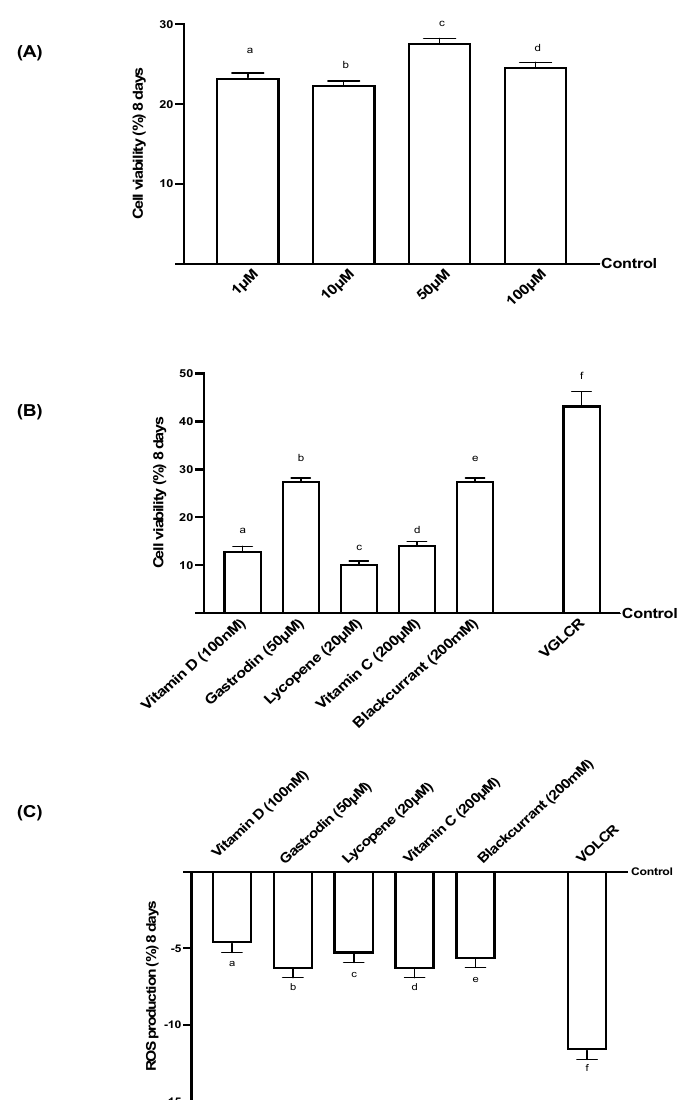
Figure 1. Cell viability and ROS production on RGC cells. In ( A ), dose-response study after gastrodin administration (1 µ M–100 µ M) on cell viability. Results are expressed as means ± SD (%) vs. control (0% line) of 4 independent experiments, each performed in triplicate. a,b,c and d is p < 0.05 vs. control; c is p < 0.05 vs. a,b and d. In ( B ), the effects of vitamin D, gastrodin, lycopene, vitamin C, blackcurrant, VGLCR = (V = vitamin D + G = gastrodin + L = lycopene + C = vitamin C + R = blackcurrant) on cell viability. In ( C ), the effects of vitamin D, gastrodin, lycopene, vitamin C, blackcurrant, VGLCR = (V = vitamin D + G= gastrodin + L= lycopene + C = vitamin C + R = blackcurrant) on ROS production. Both ( B , C ) results are expressed as means ± SD (%) vs. control (0% line) of 4 independent experiments, each performed in triplicate. a,b,c,d,e and f p < 0.05 vs. control; f is p < 0.05 vs. a,b,c,d and e.